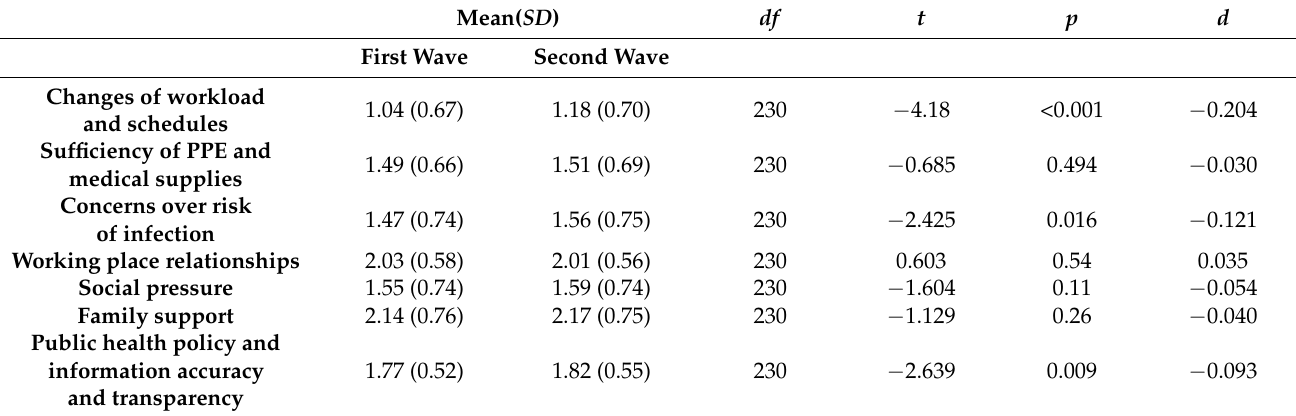
Table 6. Paired t -test comparing extrinsic factors during first and second